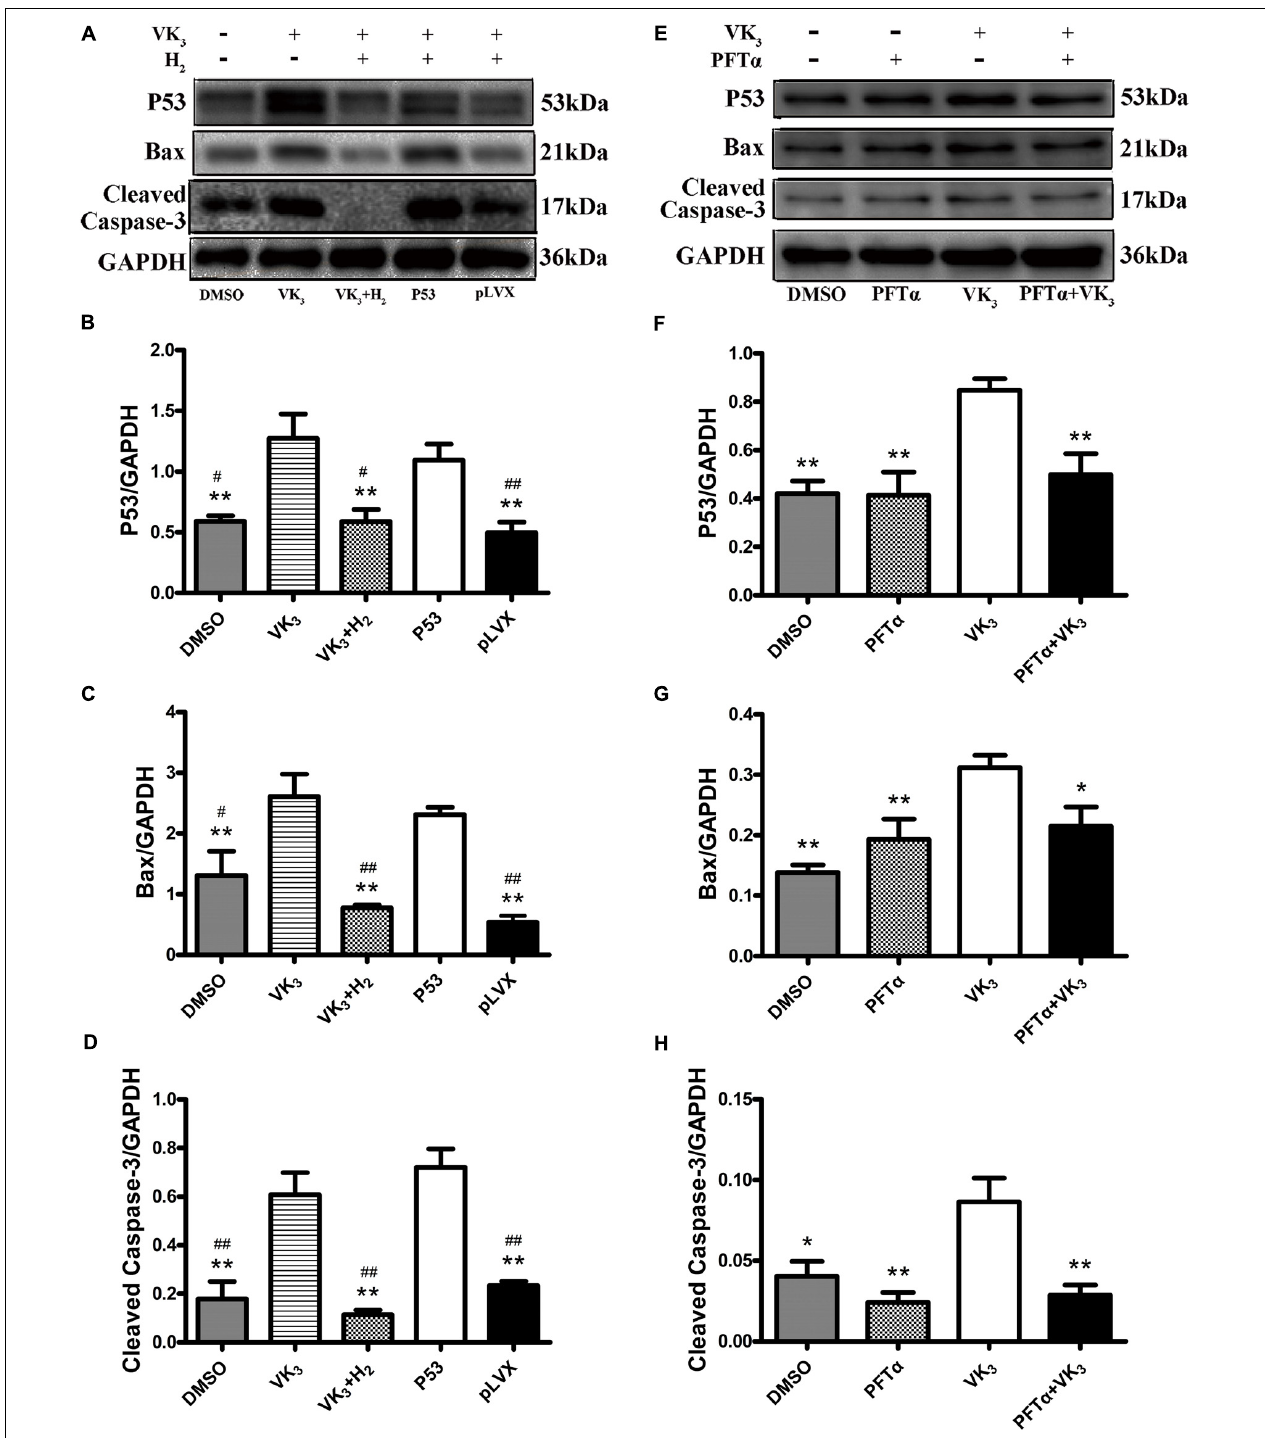
FIGURE 6 | Analysis for effects of H 2 on the expression of p53 in H9c2 cells. (A–D) Overexpression of p53 in H9c2 cells. In the groups of P53 and pLVX, H9c2 cells were infected with p53-lentivirus or pLVX and were selected for 72 h. Then the cells were treated with 10 µ M VK 3 and 75% H 2 for 8 h. In the groups of DMSO, VK 3 and VK 3 +H 2 , the cells were treated as the primary cardiomyocytes. (E–H) Inhibition of p53 in H9c2 cells. H9c2 cells were treated with 10 µ M PFT α or equivoluminal DMSO for 16 h (DMEM group and PFT α ), and then treated with 10 µ M VK3 for 8 h (VK3 group and PFT α +VK 3 group). Western blot analysis was performed on 100 g cell lysates with antibodies against p53, Bax, or cleaved caspase-3. GAPDH was used as a loading control. Expressions of p53, Bax, and cleaved caspase-3 were, respectively, quantified as folds of GAPDH ( n = 3–4). The columns indicate the mean, and the bars indicate the SE. ∗ p < 0.05 vs. VK 3 ; ∗∗ p < 0.01 vs. VK 3 ; # p < 0.05 vs. P53; ## p < 0.01 vs. P53.